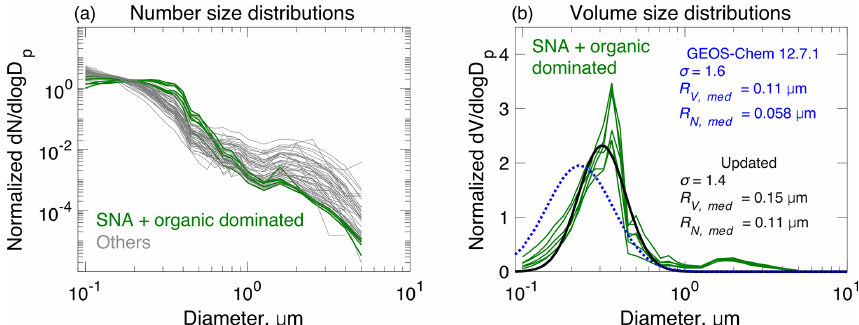
Figure 2. Aerosol dry size distributions measured in the KORUS-AQ aircraft campaign. Panel (a) shows mean normalized number size distributions measured on each of the 20 flights and for 3 altitude bins: < 1.5, 3–5, and 6–7km (60 lines total). The SNA + organic-aerosol- dominated size distribution profiles are highlighted in color. Panel (b) shows normalized volume size distributions for conditions dominated by SNA + organic aerosols (green lines), along with a least-square fit to a lognormal distribution (black line) and the standard GEOS-Chem v12.7.1 size distribution from Latimer and Martin (2019) (dashed blue line). Normalization imposes an arbitrary value of unit area below each line. Lognormal distribution parameters are inset in panel (b) , including volume median radius ( R V , med ), number median radius ( R N , med ), and geometric standard deviation ( σ